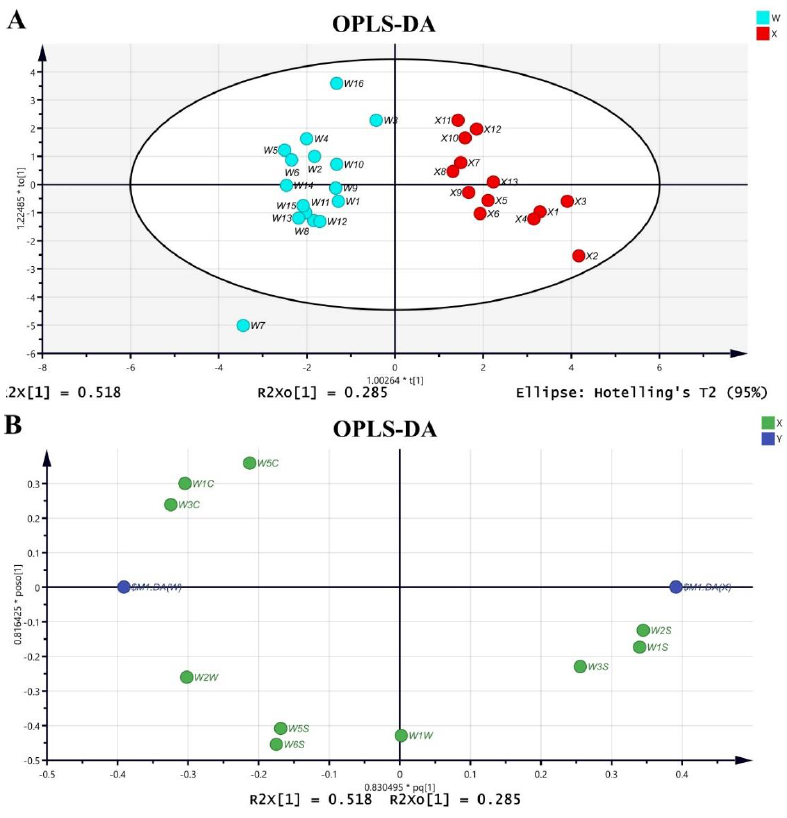
Figure 2. OPLS-DA of Acanthopanacis Cortex and Periplocae Cortex. ( A ) OPLS-DA score plot representing the samples; ( B ) OPLS-DA loading plot representing the variables.